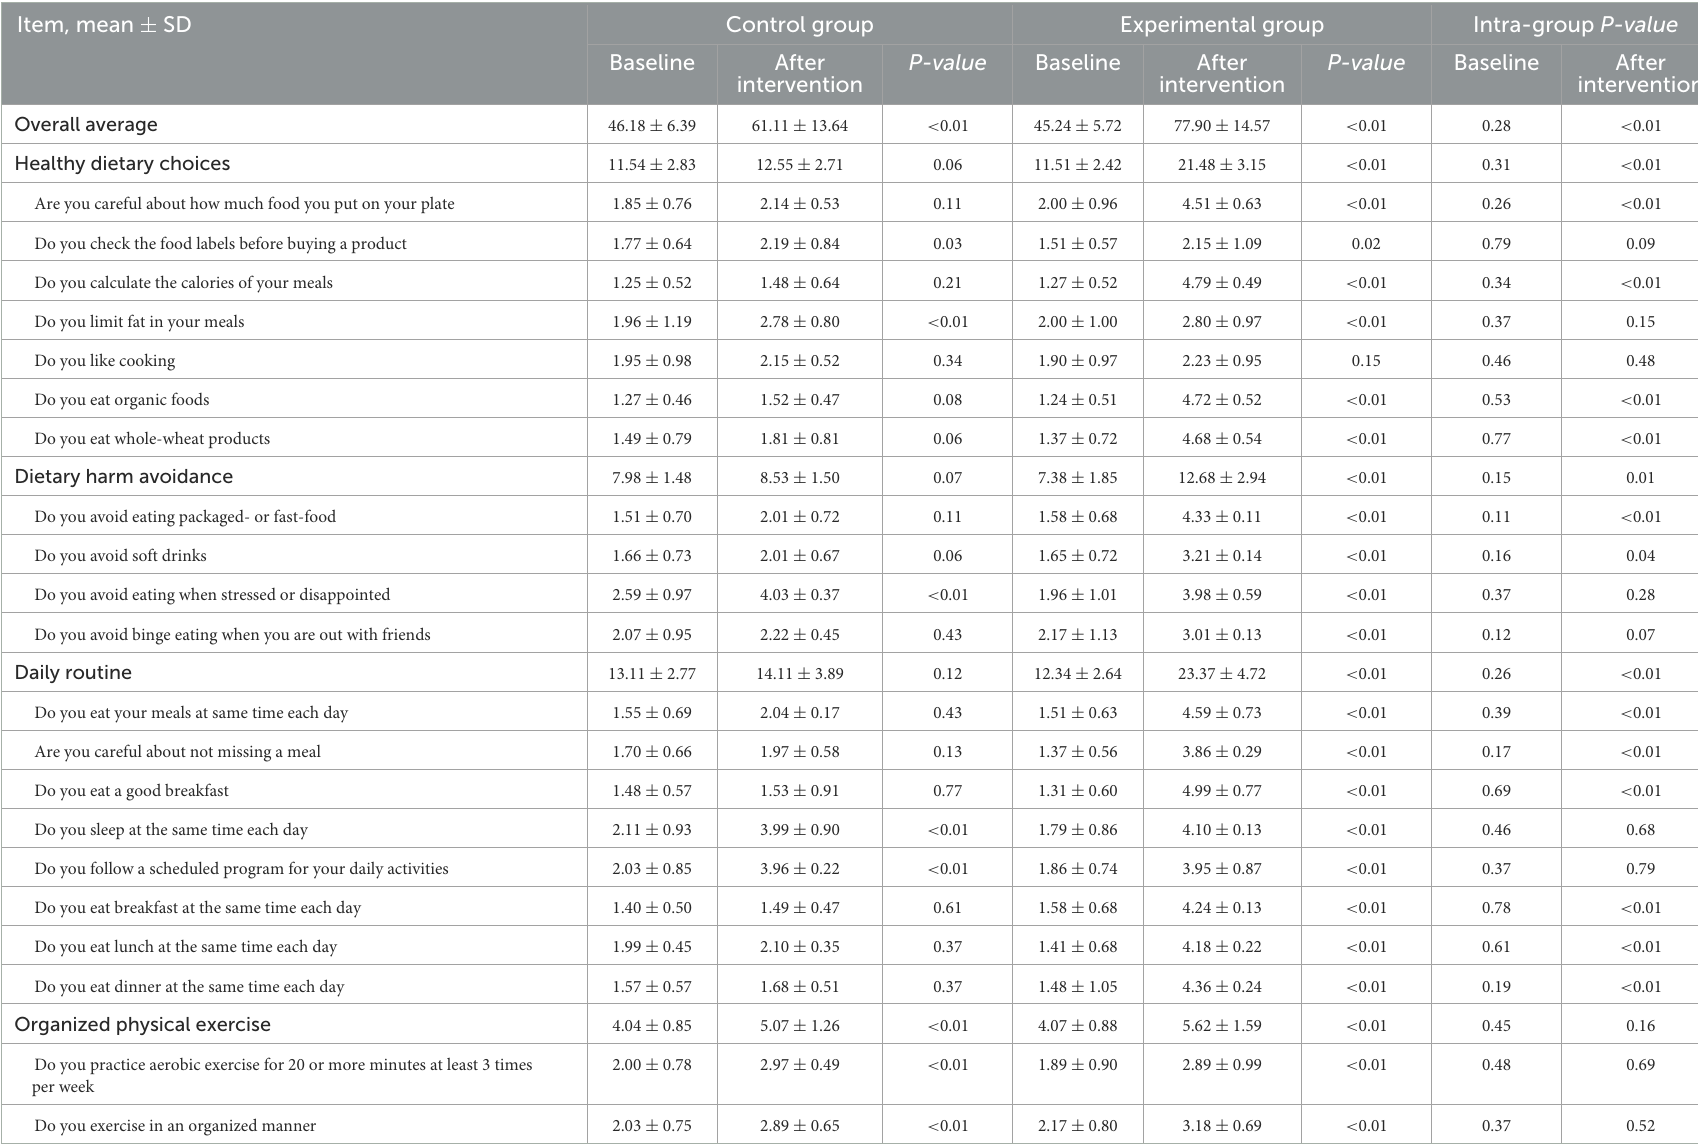
P-value Baseline After P-value Baseline After Baseline After intervention intervention intervention